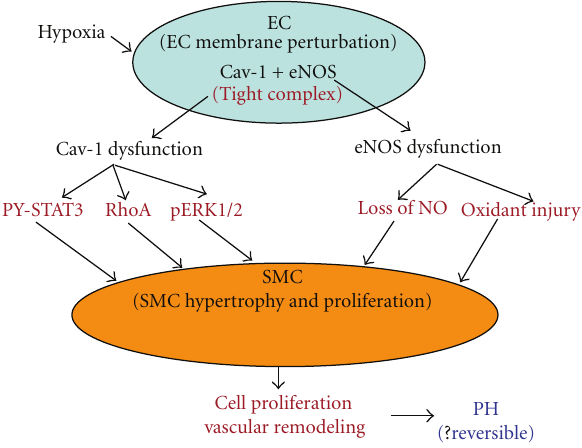
Figure 3: This figure depicts the proposed model of PH (#2). Hypo- xia causes perturbation of endothelial cell membrane, and caveolin- 1 and eNOS form a tight complex rendering both molecules dysfunctional. eNOS dysfunction function leads to impaired NO availability and superoxide generation, and dysfunctional caveolin- 1 loses its ability to inhibit proliferative pathways resulting in the activation of mitogenic pathways. The end results are pulmonary vascular remodeling and